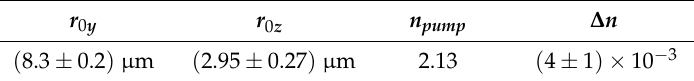
Table 1. Measured waveguide parameters.